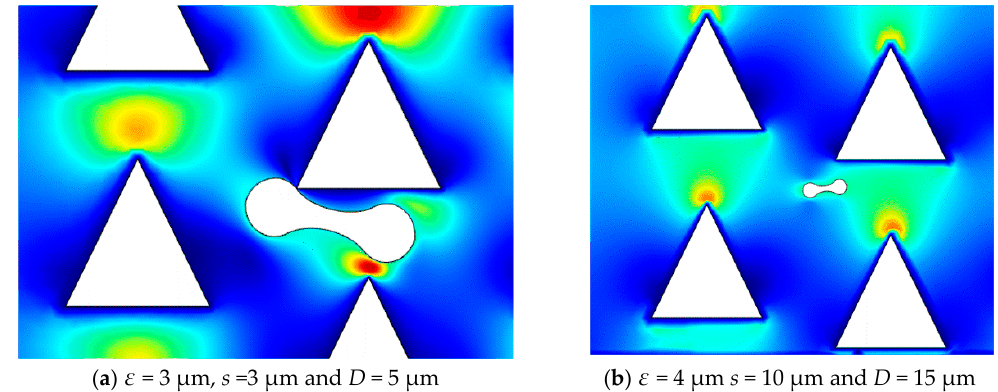
Figure 12. Snapshot of RBCs in the triangular arrays with s = 3 µm and D = 5 µm and s = 10 µm and D = 15 µm.